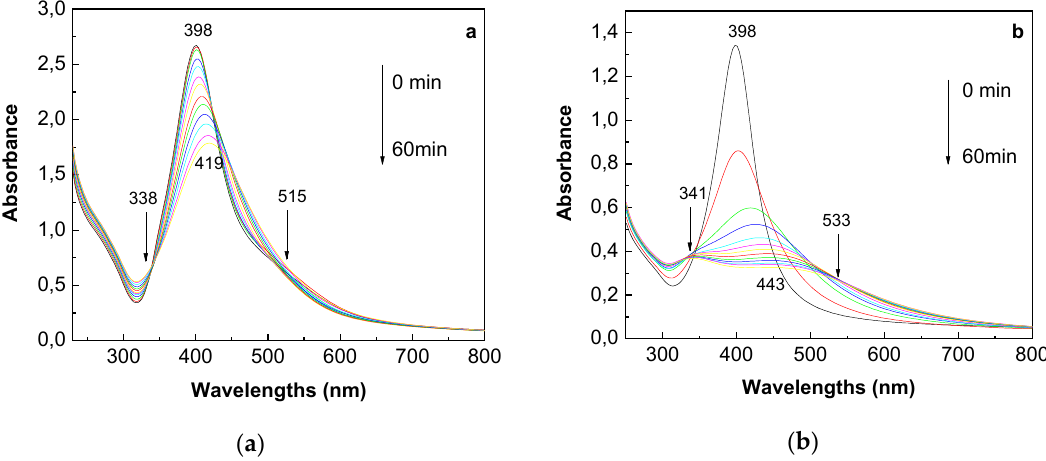
Figure 6. UV-VIS spectra of the ALA solution in the presence of excipients (commercial product marketed under the name of Alpha Lipoic Sustain) in the presence of Ag nanoparticles with sizes of 5 nm ( a ) and 10 nm ( b ), with a concentration of 1 mg / mL, and their changes at the exposure to UV light. The two samples’ UV-VIS spectra were recorded at intervals of 5 min of exposure to UV light for 60